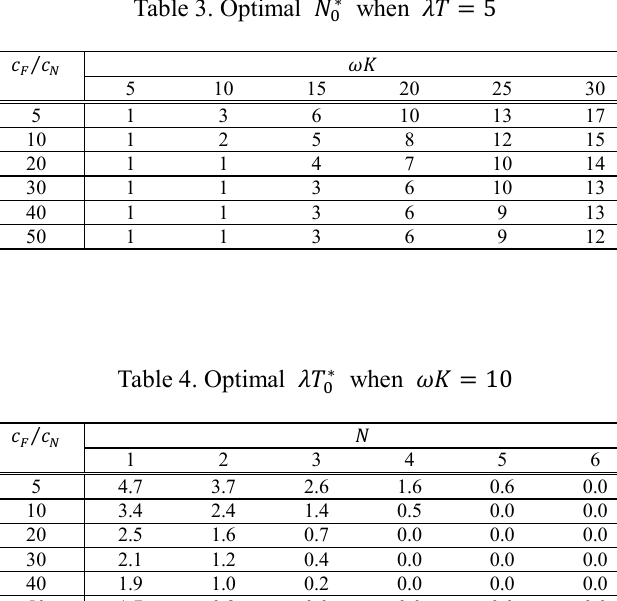
Table 3. Optimal 𝑁 0∗ when 𝜆𝑇 = 5